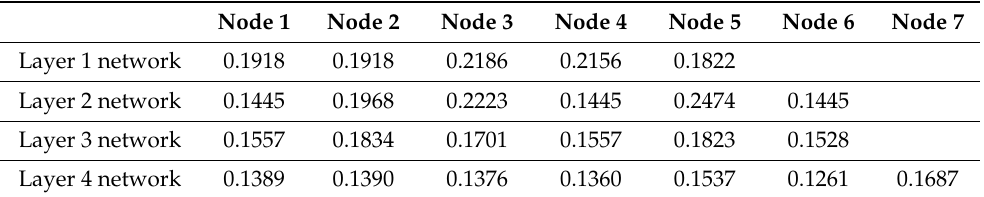
Table 6. Node importance value.